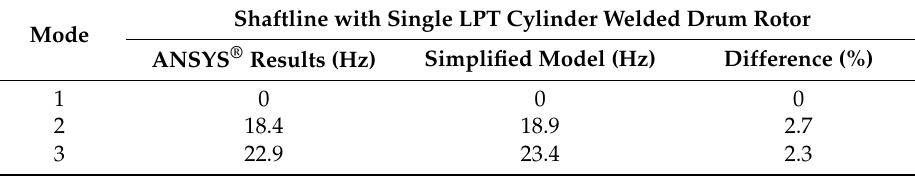
Table 6. Comparison of torsional frequencies.